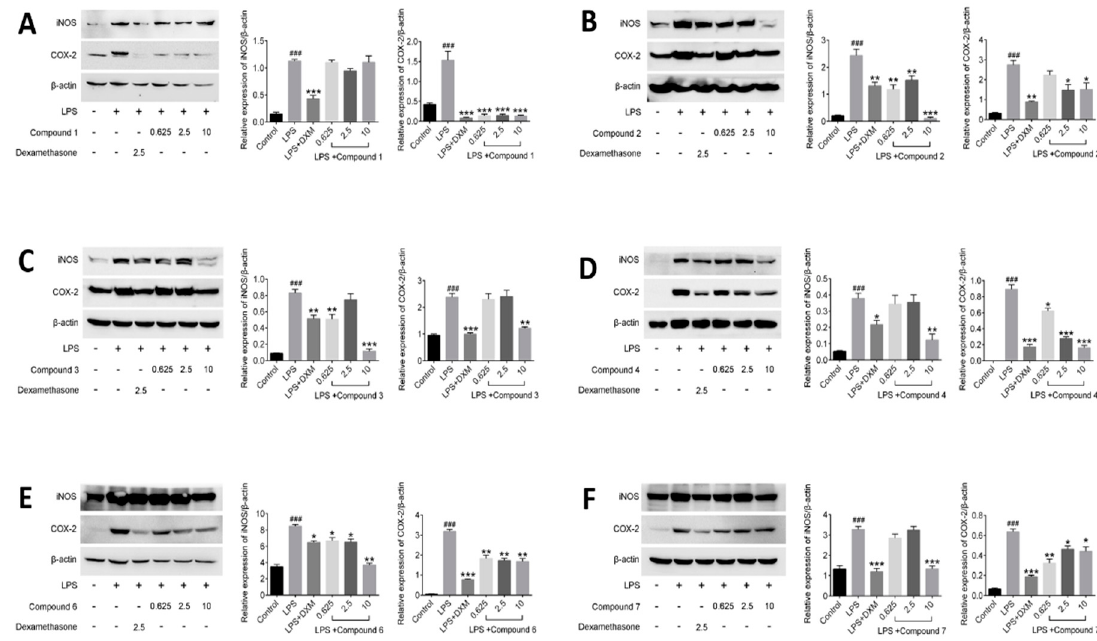
Figure 6. Effects of compounds on iNOS and COX-2 protein expressions in LPS-stimulated RAW264.7 cells. RAW264.7 macrophages were pretreated with various concentrations of compounds for 1 h prior to LPS (1 μ g/mL) treatment. Using β -actin expression as an internal control. Data shown represent the mean value ± SD ( n = 3). ### p < 0.001 when compared with control versus LPS; *** p < 0.001, ** p < 0.01, * p < 0.05 as compared to the group treated with LPS alone.